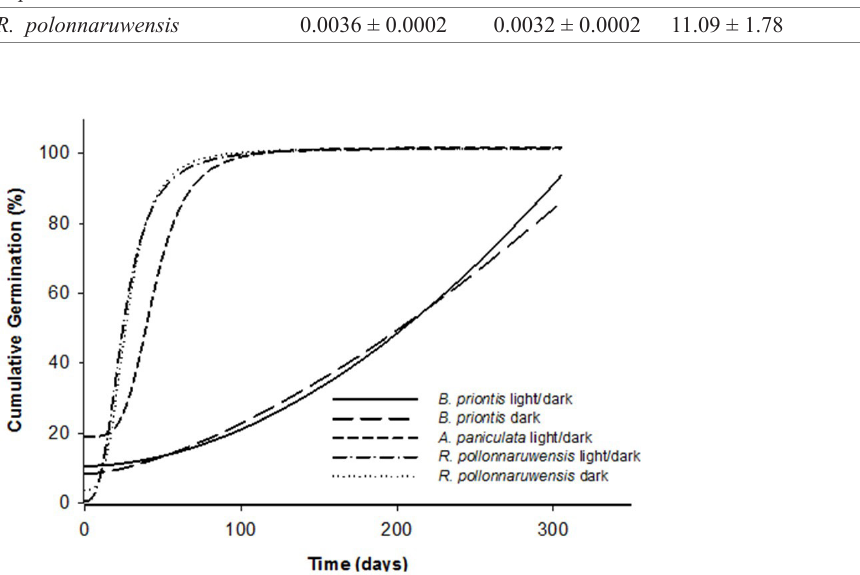
Figure 1: Cumulative germination of A. paniculata var. paniculata, B. prionitis and R. polonnaruwensis. Weibull 5 parameter sigmoidal curves fitted to the actual data to model the germination with